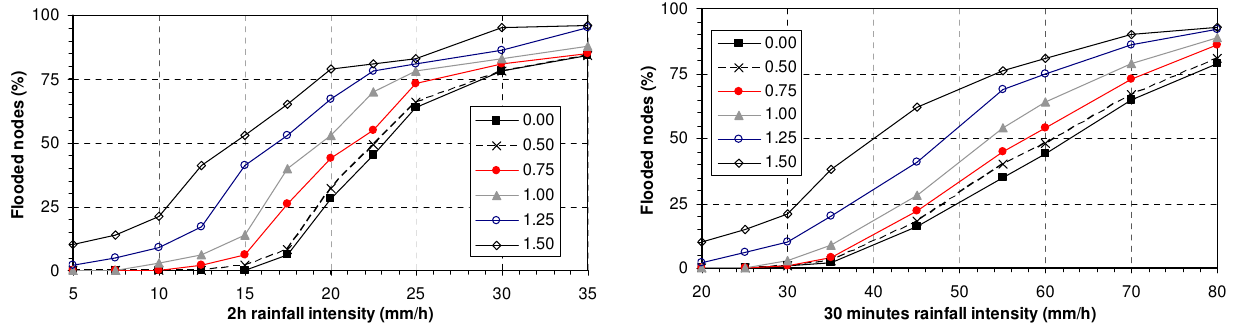
Fig. 7. Percentage of network nodes flooded as a function of constant rainfall intensity (Duration: 2h, left panel; 30min, right panel) and of sea level at network outfall, supposed variable between 0 and